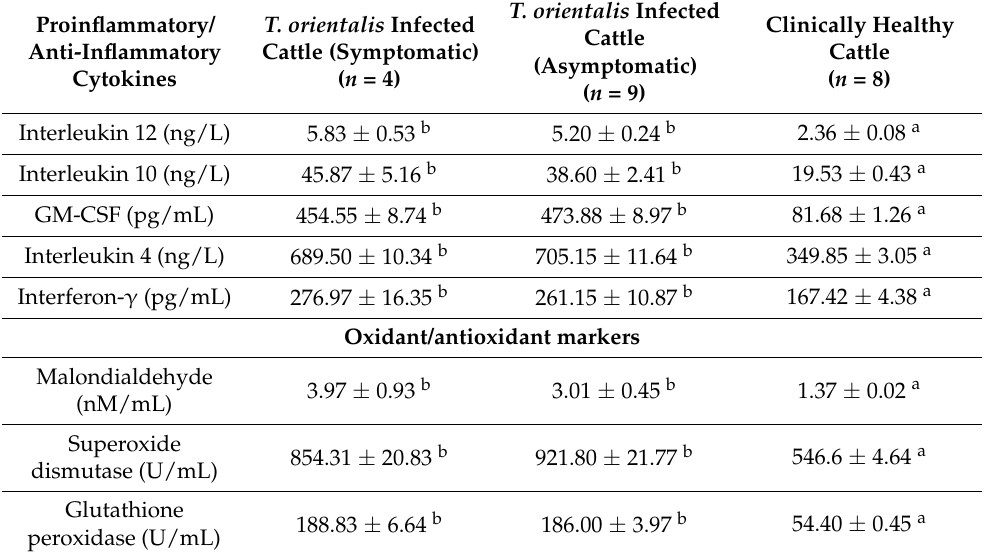
Table 4. The serum inflammatory cytokine and oxidant/antioxidant levels in symptomatic and asymptomatic cattle in cattle naturally infected by Theileria orientalis . T. orientalis Infected T. orientalis Infected Clinically Healthy Proinflammatory/ Cattle Cattle Cattle (Symptomatic) Anti-Inflammatory (Asymptomatic) ( n = 8) ( n = 4) Cytokines ( n = 9) Interleukin 12